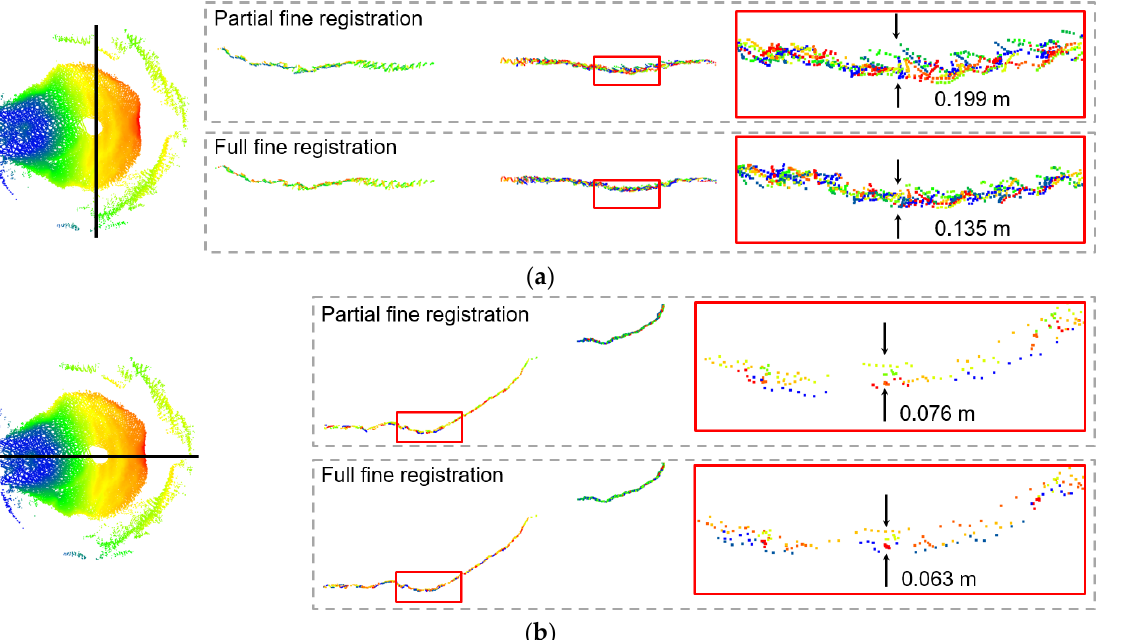
( b ) Figure 35. Extracted edge points from all scans of the Lebanon dataset ( a ) before and ( b ) after full fine registration. To quantitatively evaluate the impact of adding roof stringers for refining the Δ𝜅 ro- tation angle, the RMS of the fitting error before and after the full fine registration, along with the number of points in each feature, are presented in Table 4 (the stringer IDs are shown in Figure 36). For the roof feature, we can see that the fitting error remained almost the same before and after the full fine registration. This should be expected because the